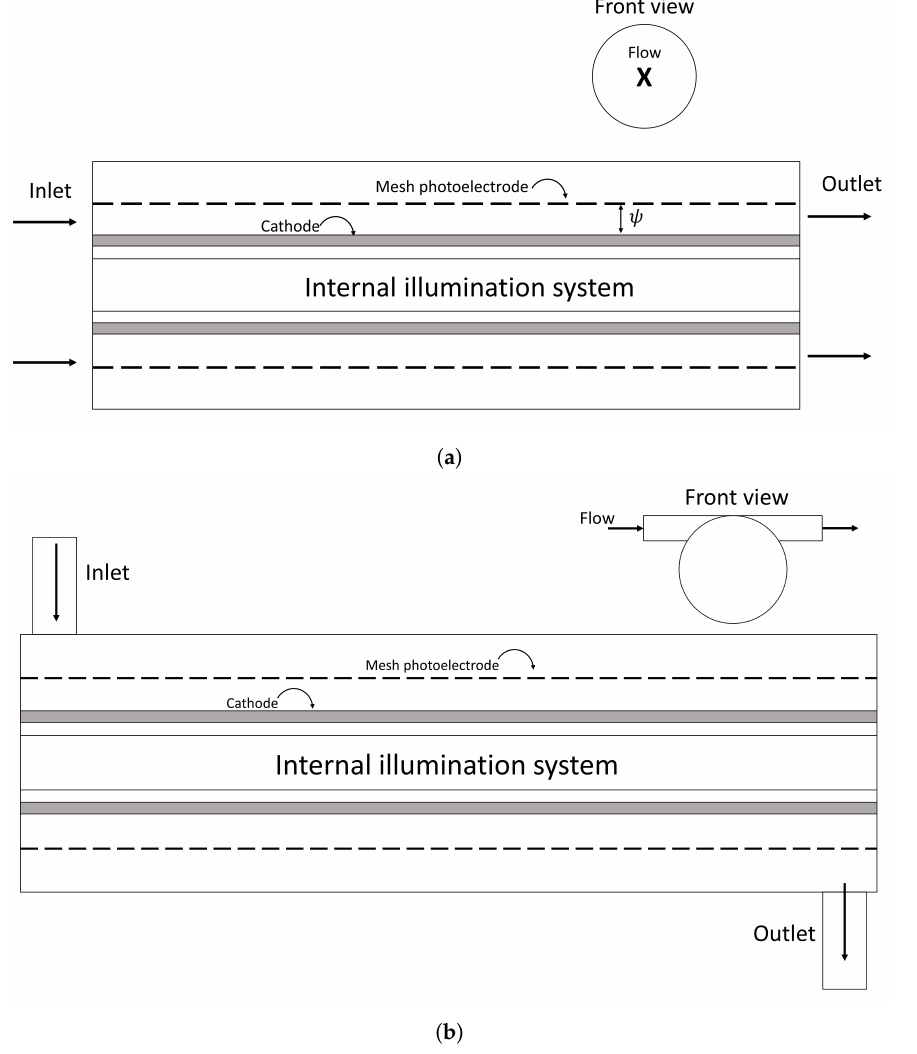
Figure 3. Photoreactor based on ( a ) Axial Flow (AF) and ( b ) Tangential Flow (TF)